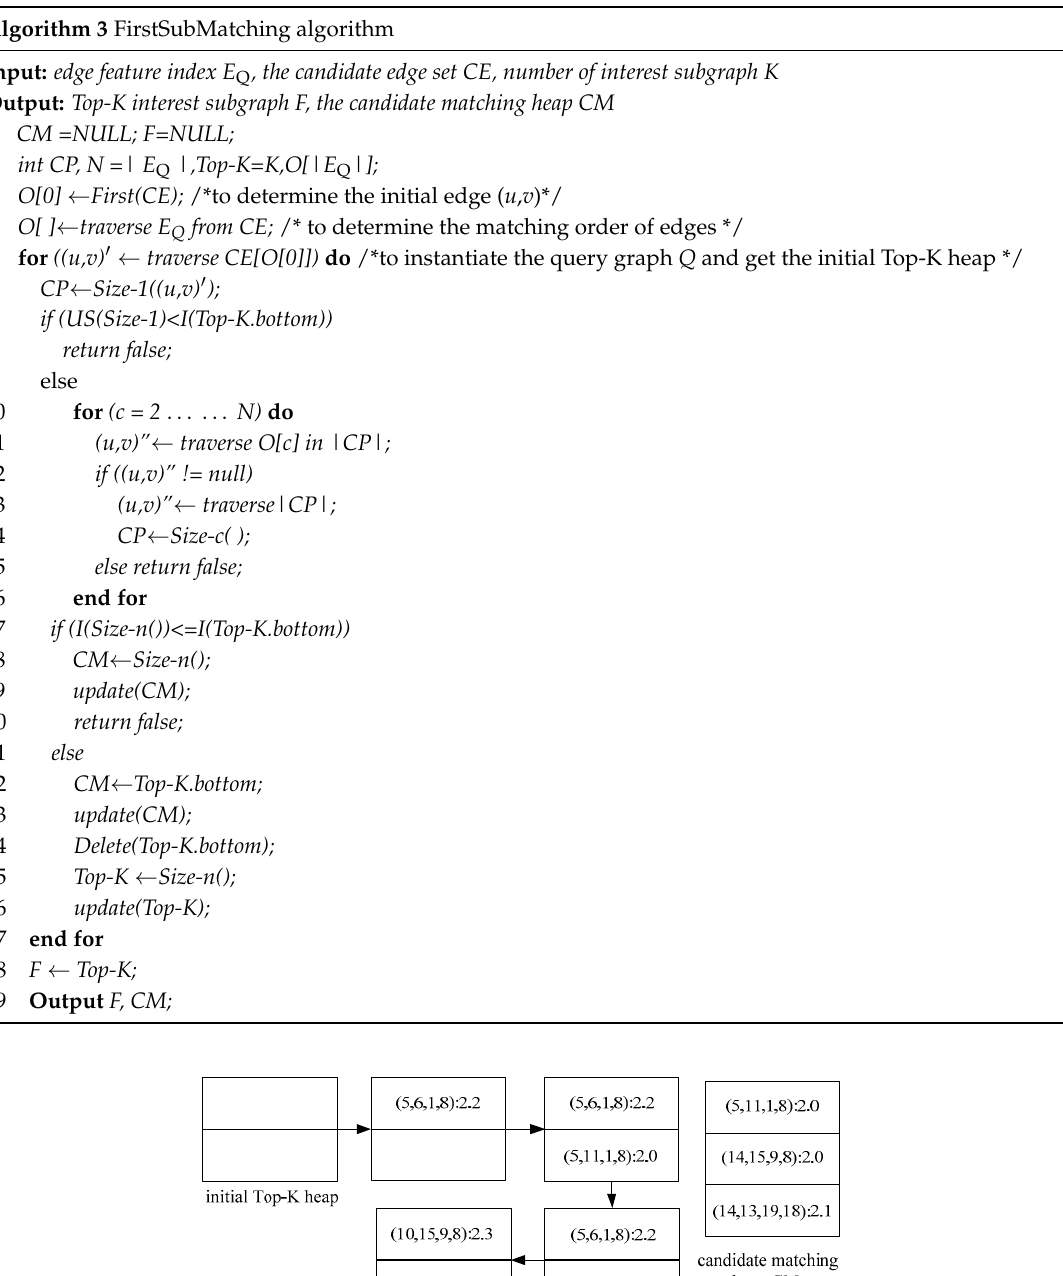
Algorithm 3 FirstSubMatching algorithm